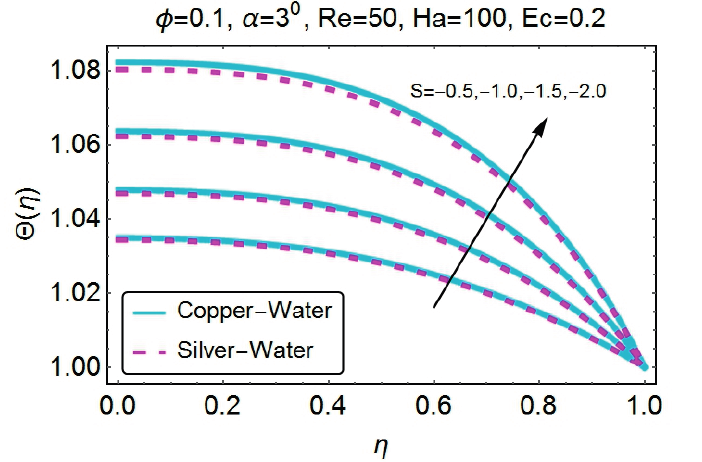
Figure 21. Change in temperature for varying S (divergent channel/shrinking